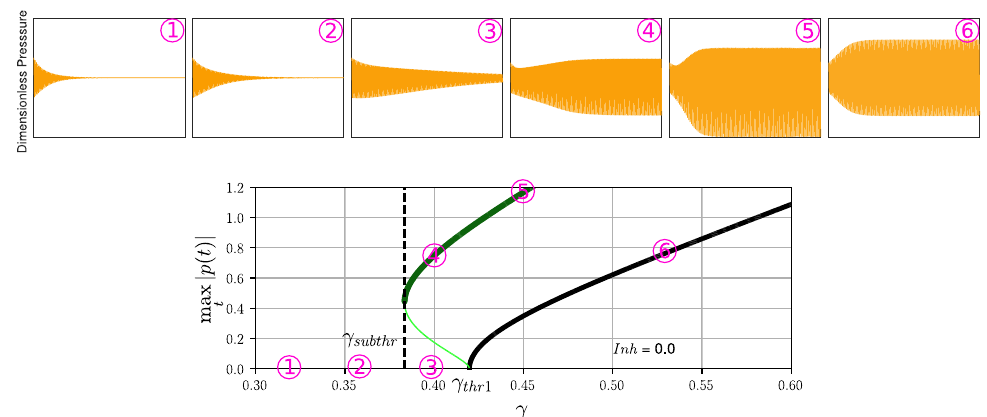
Figure 2. Bifurcation diagram and time domain simulations of the two harmonic resonance air column (parameter ’ s values in Tab. 1 with Z 2 = Z 1 /1.5 or with Z 2 = 0, and Inh = 0) with respect to the control parameter c . Upper plots: six time domain simulations of the dimensionless pressure p = p 1 + p 2 calculated between t = 0 and t = 0.5 s for c = 0.32, c = 0.36, c = 0.40 (two simulations with different initial conditions), c = 0.45 and c = 0.53. The dimensionless pressure of the plots numbered from 1 to 3 (respectively 4 to 6) is displayed between (cid:1) 0.3 and +0.3 (respectively (cid:1) 1.2 and +1.2). Lower plot: Maximum of the absolute value of the periodic solution p over one period with respect to c . The branch in green (respectively in black) corresponds to the case Z 2 = Z 1 /1.5 (respectively Z 2 = 0), and illustrates an inverse (respectively direct) Hopf bifurcation scenario. Stable (respectively unstable) solutions are plotted with thick (respectively thin) lines. For each scenario, the Hopf bifurcation point where the equilibrium becomes unstable, is noted c thr . In the case of an inverse bifurcation the subcrital threshold c subthr is highlighted with a vertical dashed line.